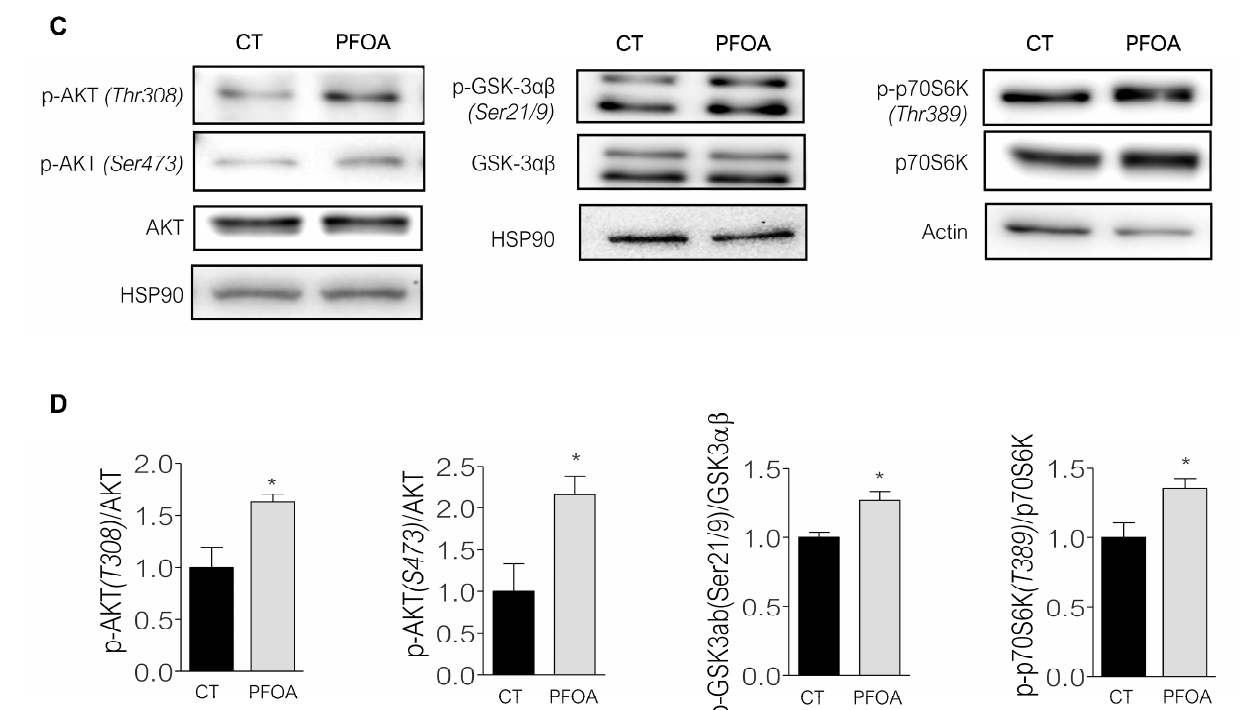
Figure 4. PFOA increases the phosphorylation of Akt and p70S6 kinase in MCF7 cells. ( A , B ) Image and quantification of Human Phospho-Kinase Array. Relative levels of protein phosphorylation of a range of 43 kinase phosphorylation sites of MCF7 cells after 48 h of treatment with PFOA (10 − 12 M) in comparison with cells exposed with EtOH (CT). ( C ) Western blot of phospho-AKT (Thr308 and Ser473), AKT total, phopsho-GSK3 αβ (Ser21/9), GSK3 αβ total, HSP90, phospho-p70S6Kinase (Thr389), p70S6Kinase total and actin of MCF7 cells protein extract after 48 h of treatment with PFOA (10 − 12 M) compared to cells treated with EtOH (CT). ( D ) Quantification of protein level of three independent western blot experiments. T test. * p < 0.05.